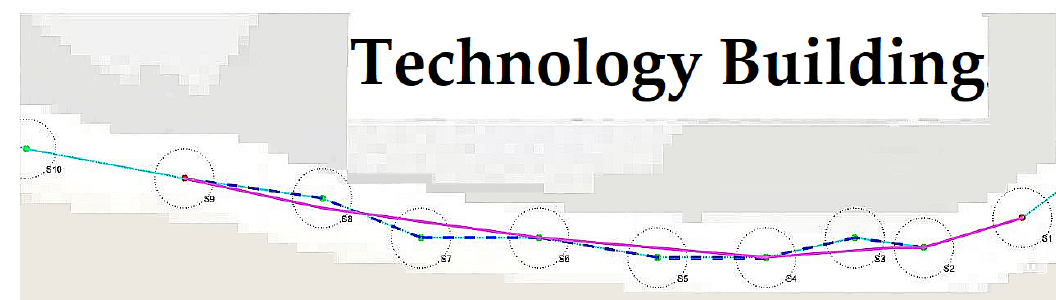
Figure 18. Path planning by Dijkstra algorithm.